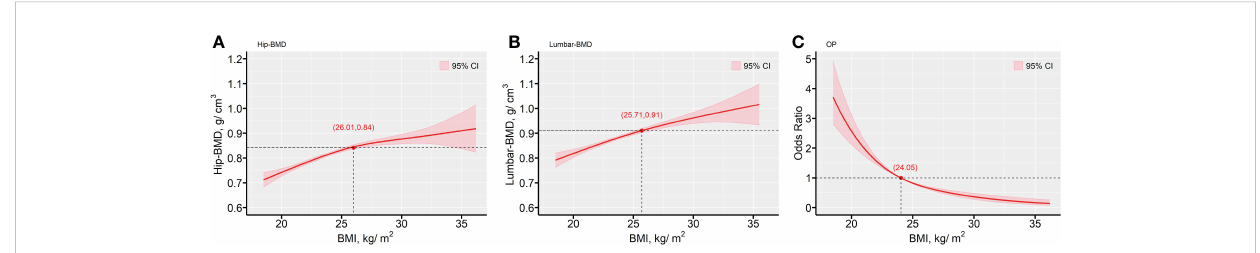
FIGURE 4 The predictive values for the outcomes of BMD biomarkers and OP risk, as functions of BMI (kg/m 2 ). (A) Hip-BMD; (B) Lumbar-BMD; (C) OP. The fi tted values are shown in red lines, with a reference line provided ( — ). The Bayesian 95% con fi dence intervals are included in with red-color areas, calculated as described in the text. All plots are from generalized varying coef fi cient models (GVCM) with penalized cubic regression splines for the smooth coef fi cient functions. Smoothing parameters were selected by the generalized cross-validation (GCV) criterion. The red points with axis values denoted the tangent points with the maximum changes of the predicted values by BMI. In all panels, multivariate analyses were adjusted for age (in years, continuous), sex (men or women), educational status, smoking status, drinking status, dietary types, family income levels, seasons, regions and MAHS (in hours, continuous). The missing data were imputed by multiple imputation and all estimations were combined across the 5 imputed datasets using the Rubin ’ s method. Hip-BMD, hip bone mineral density; Lumbar-BMD, lumbar bone mineral density; OP, osteoporosis; OR, odds ratio; MAHS, mean annual hours sunshine; BMI, body mass